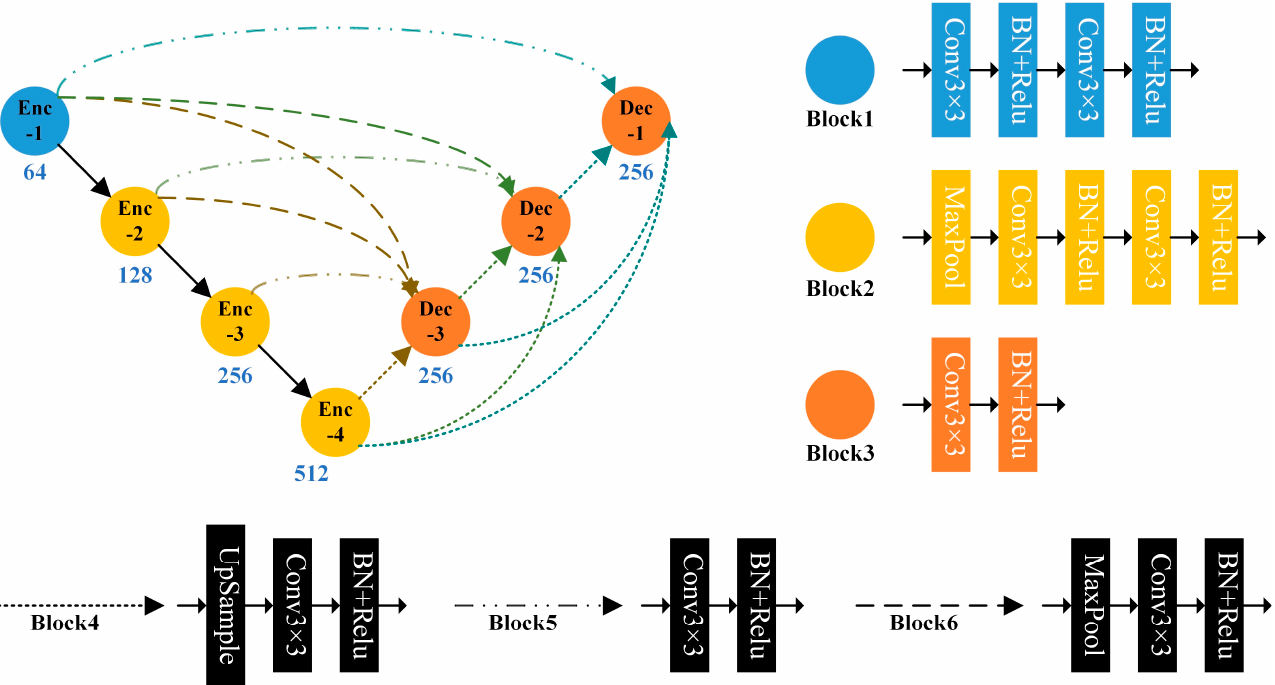
Figure 7. Architecture diagram of Polar-UNet3+. The detailed convolution configurations are represented by different colors and line styles.